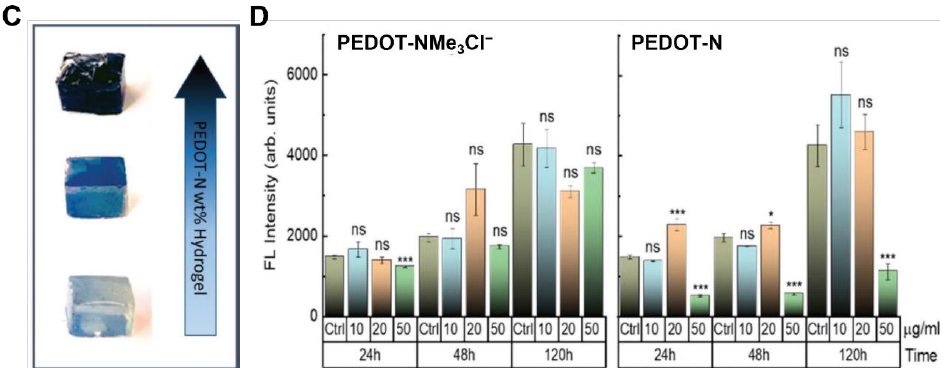
Figure 6. Scheme of the synthesis of PEDOT-N homopolymer and PEDOT-co-PEDOT-N copolymers ( A ). SEM of thin films obtained by casting aqueous solutions of PEDOT-N homopolymer, 50% PEDOT-N, and 100% PEDOT-N ( B ). Pictures of hydrogels containing a decreasing amount of PEDOT-N polymer ( C ). Cell proliferation tests on HEK-293 cell models exposed to different cationic PEDOT-N polymer dispersion concentrations, at different time points after plating. Two counter ions were studied: Cl− and I− (left and right panel, respectively). Error bars represent the standard deviation of the mean. ( D ) Adapted with permission from reference [22]. Copyright 2020 John Wiley and Sons.